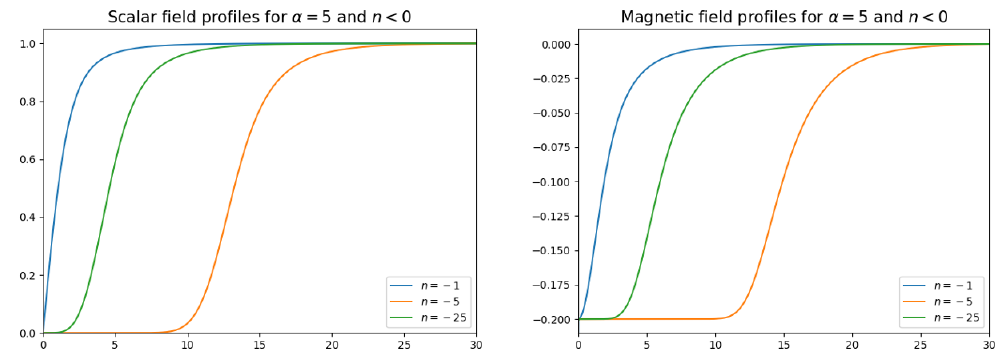
Figure 2 . Left : the scalar (cid:12)eld pro(cid:12)le ~ f (~ r ) for (cid:11) = 5 and negative (cid:13)ux. Right: the dimensionless magnetic (cid:12)eld ~ B (~ r ) for the same values of (cid:11) and magnetic